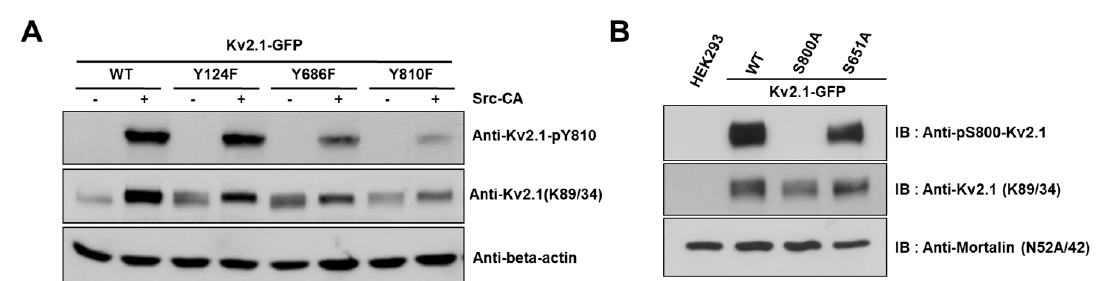
Figure 3. Analysis of the K v 2.1 channel tyrosine phosphorylation sites. Phospho-specific tyrosine antibodies were generated against the S800 phosphorylation site (anti-pS800-K v 2.1, in-house) and the Y810 phosphorylation site (anti-pY810-K v 2.1, in-house) on the K v 2.1 channel. ( A ) HEK293 cells were co-transfected with K v 2.1-WT or the channel mutations (Y124F, Y686F, and Y810F) and Src-CA.